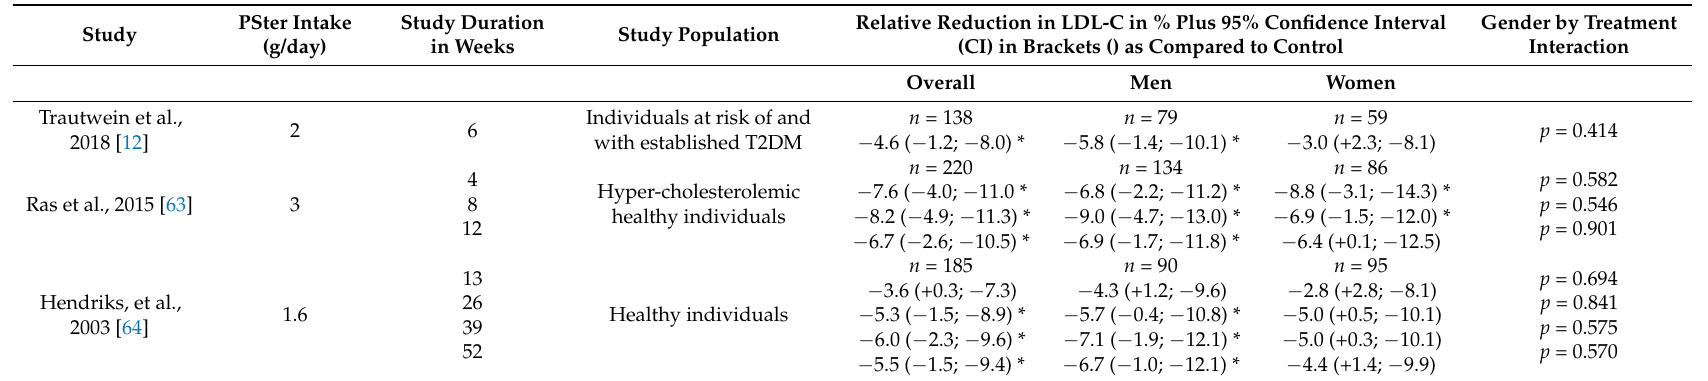
Table 4. LDL-cholesterol (LDL-C) lowering effect of plant sterol (PSter) intake separated for men and women based on previously published intervention